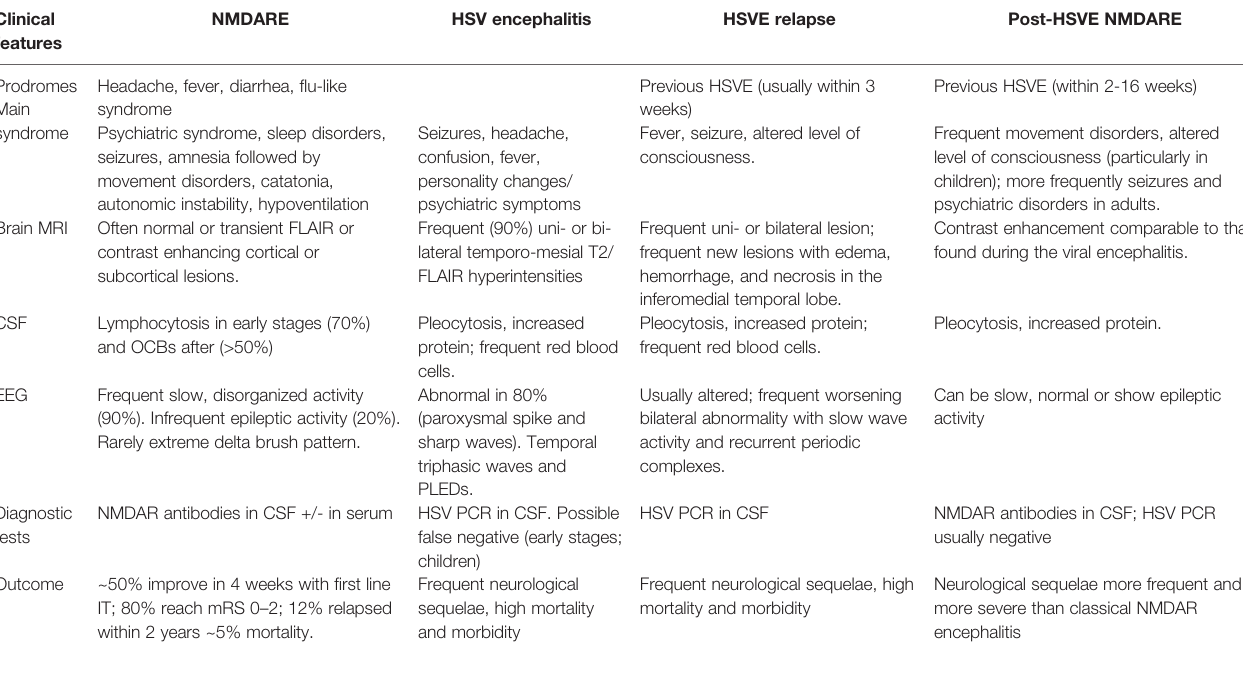
TABLE 3 | Clinical features and differential diagnosis between NMDARE, HSVE and relapse and post-HSVE NMDARE. Clinical